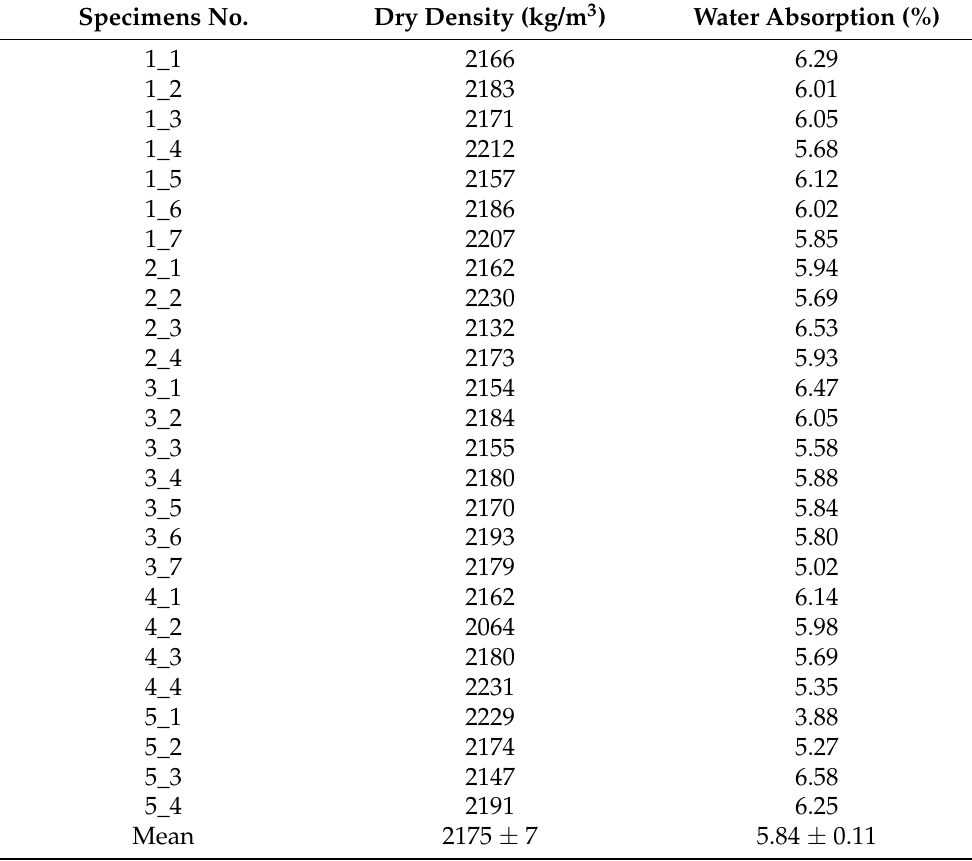
Table 2. Dry density and water